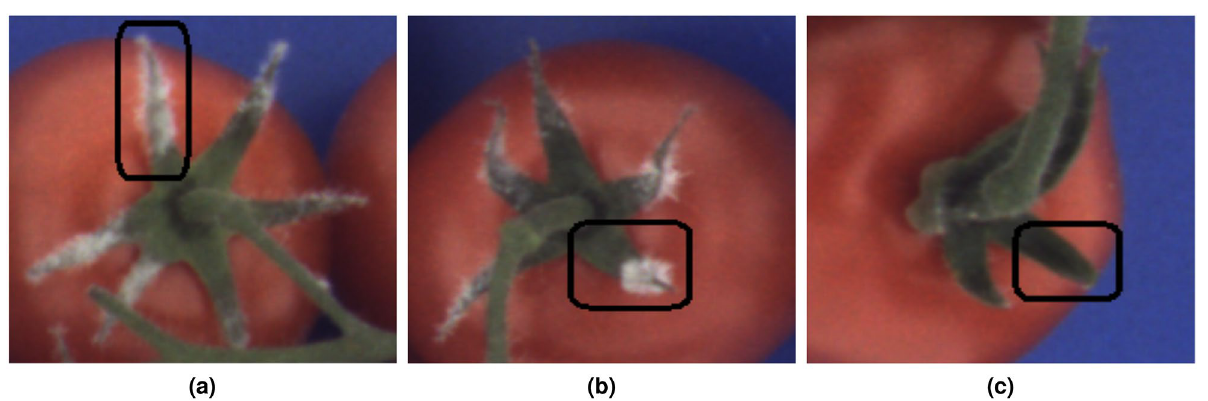
Figure 14. Examples of sepals with different levels of infection: ( a ) severe infection, ( b ) moderate infection, ( c ) no